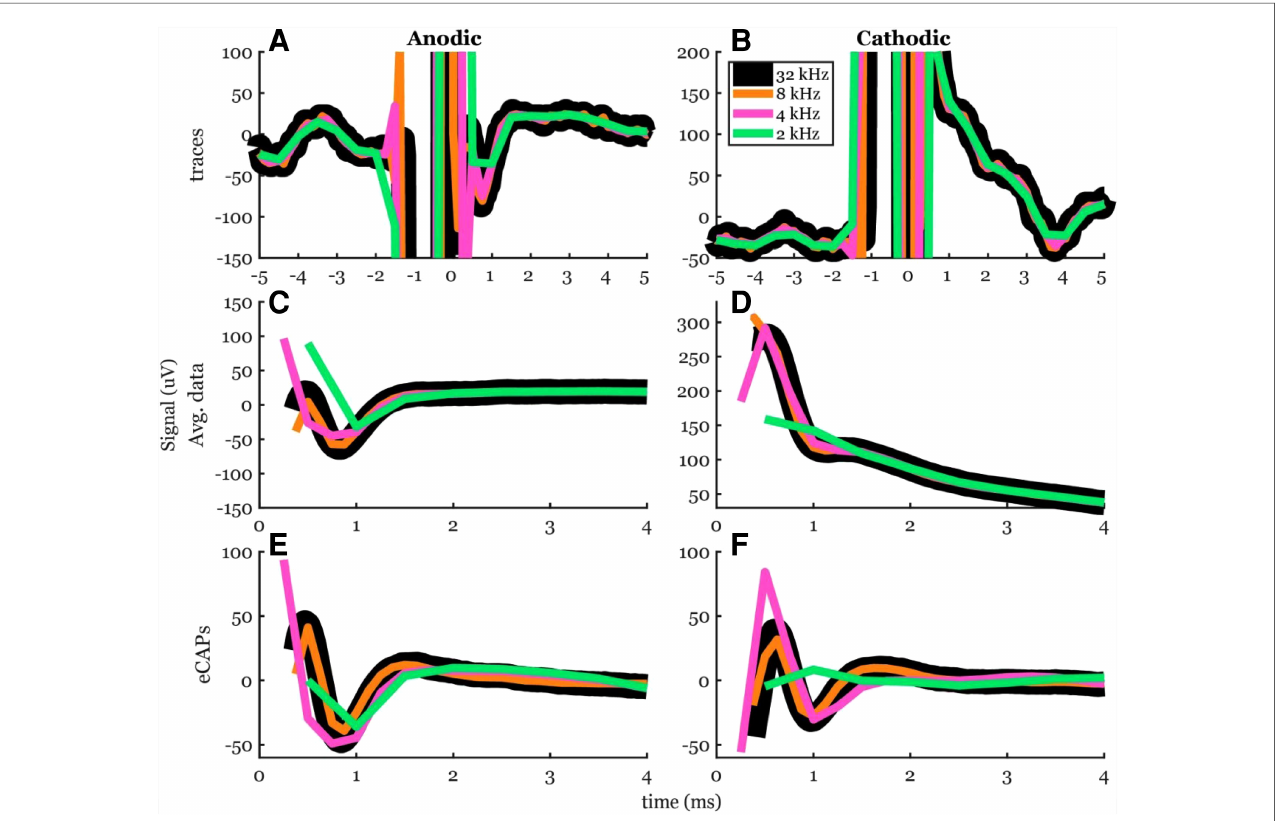
FIGURE 9 Effect of sampling rate on ECAP morphology. ( A,B ) Example time traces at the original 32 kHz and the down-sampled 8, 4, and 2 kHz with an of fl ine antialiasing fi lter. ( C,D ) The traces ’ average within the fi t window for stim artifact removal. ( E,F ) The resulting anodic and cathodic ECAPS